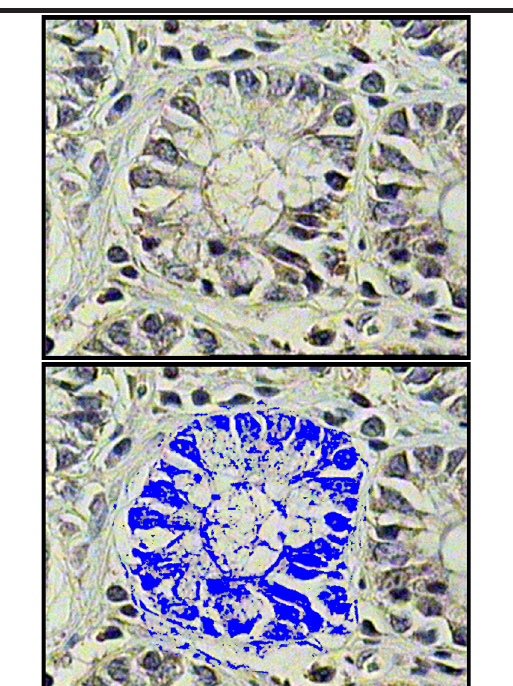
FIGURE 1 - Capture image exemplification the quantification area with the expression SOD1 (area blue).